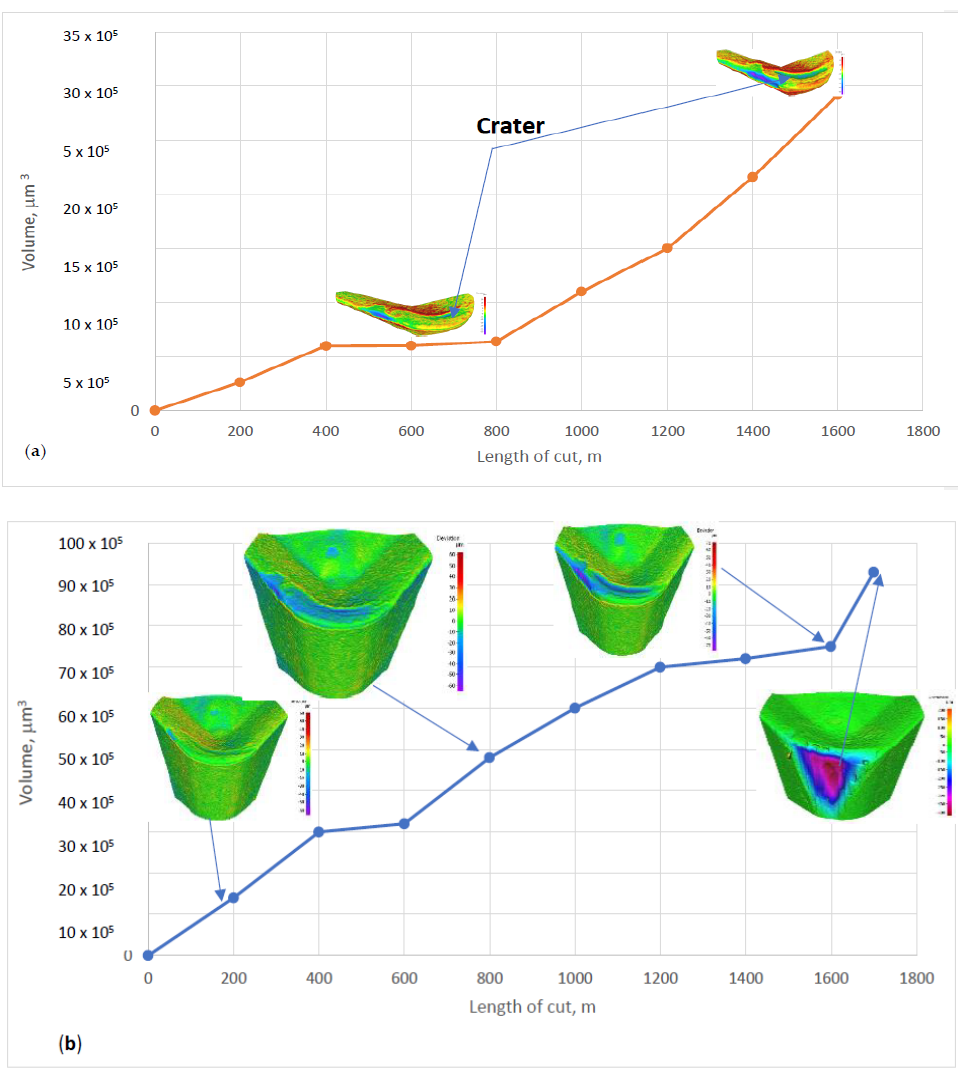
Figure 5. Quantitative data on the 3D wear volume ( a ) and crater wear ( b ) volume of the cutting tool vs. length of cut .